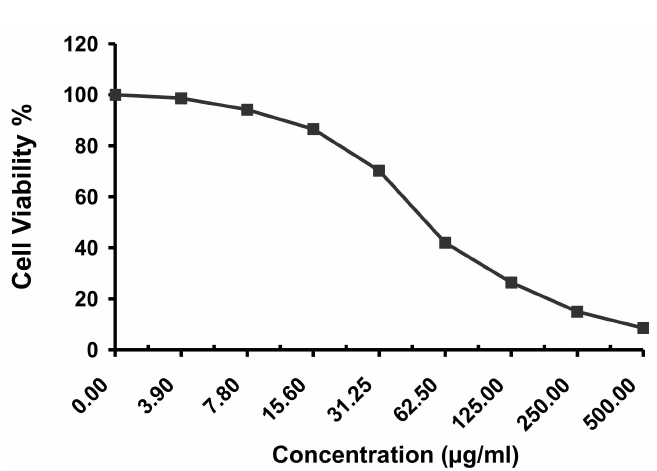
Figure 12. HepG-2 of dye 30h .